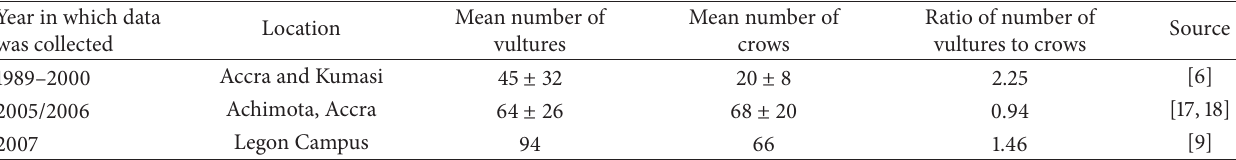
Table 2: Results of literature search on simultaneous count of crows and vultures in Ghana.